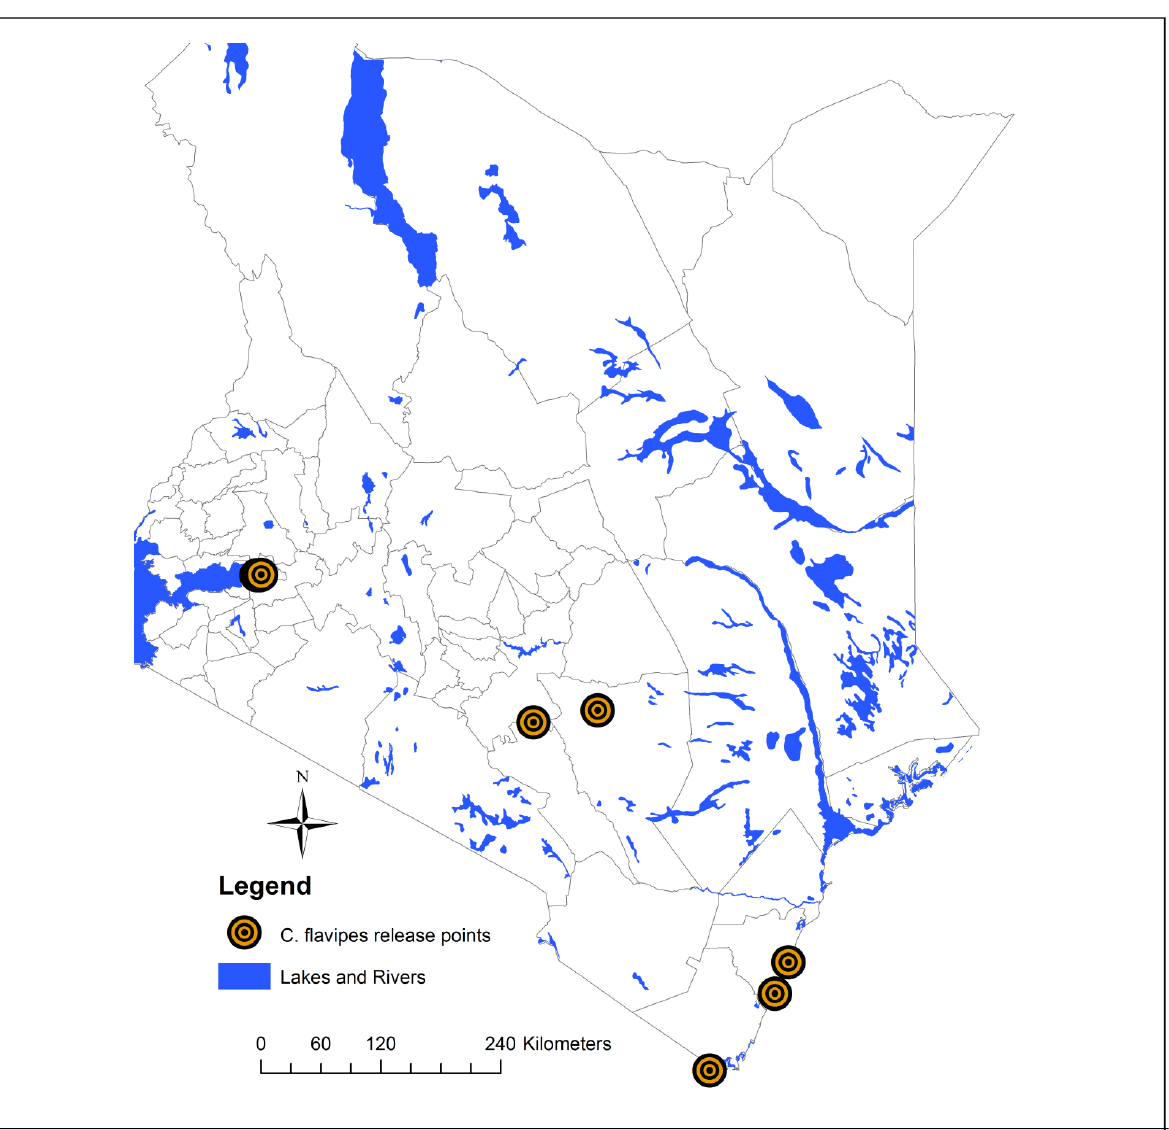
Figure 1: Cotesia flavipes release points in three agro-ecological zones in